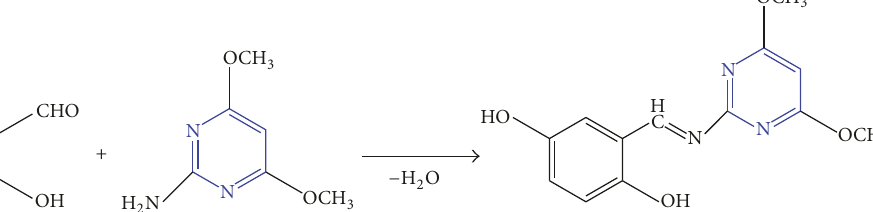
Scheme 1: Synthetic route of ligand HL .